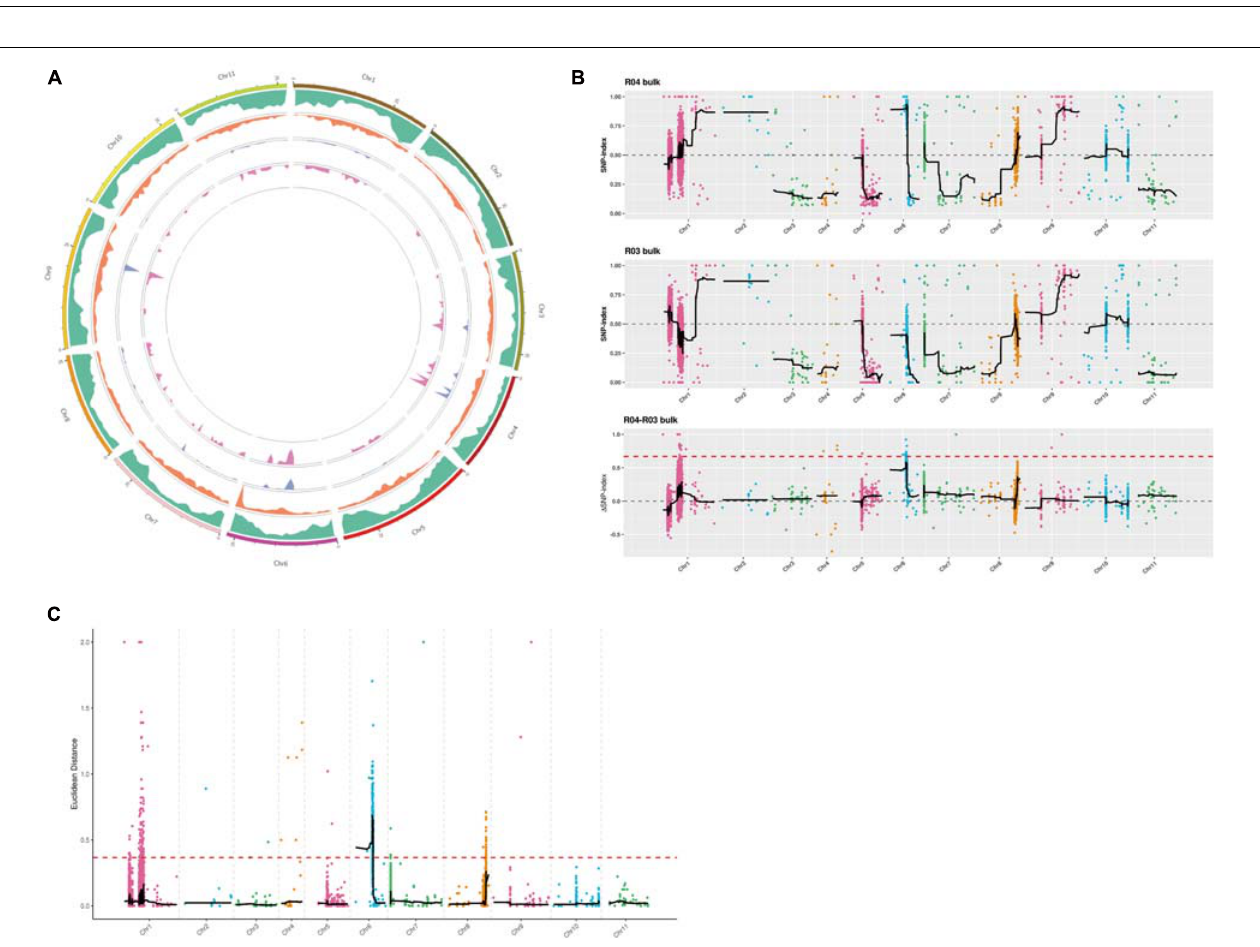
FIGURE 4 | (A) Chromosomal distribution of the candidate regions determined using Circos software. From the outside to the inside : first circle : chromosomal coordinates; second circle : gene distribution; third circle : single nucleotide polymorphism (SNP) density distribution; fourth circle : Euclidean distance (ED) value distribution; fifth circle : (cid:49) SNP index value distribution. (B) Layout of the (cid:49) SNP index value distribution. The x -axis presents the watermelon chromosome numbers. The colored dots represent the calculated SNP index (or (cid:49) SNP index) values. The black lines represent the fitted SNP index (or (cid:49) SNP index) values. The top figure presents the SNP index value distribution in the male-sterile sample mixed pool. The middle figure presents the SNP index value distribution in the male-fertile sample mixed pool. The bottom figure presents the (cid:49) SNP index value distribution, with the red line indicating the 99th percentile threshold. (C) ED value distribution. The threshold is indicated by a red dashed line . The x -axis presents the watermelon chromosome numbers.